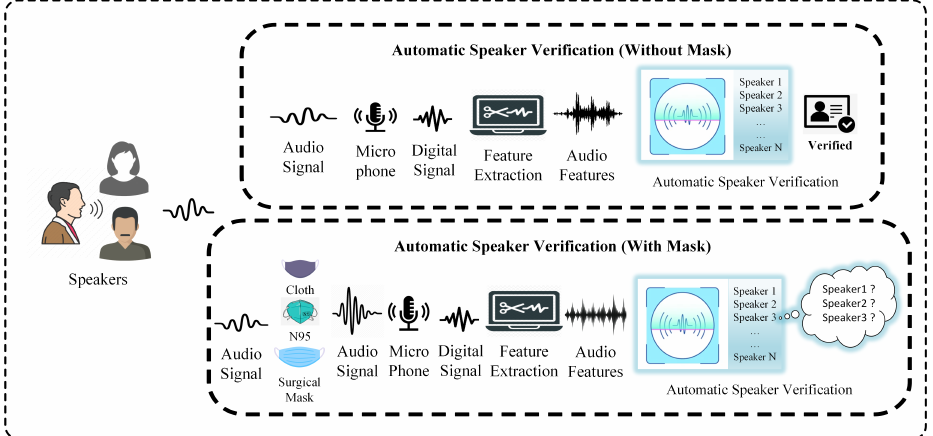
Figure 3. The impact of commonly used face masks on existing ASV